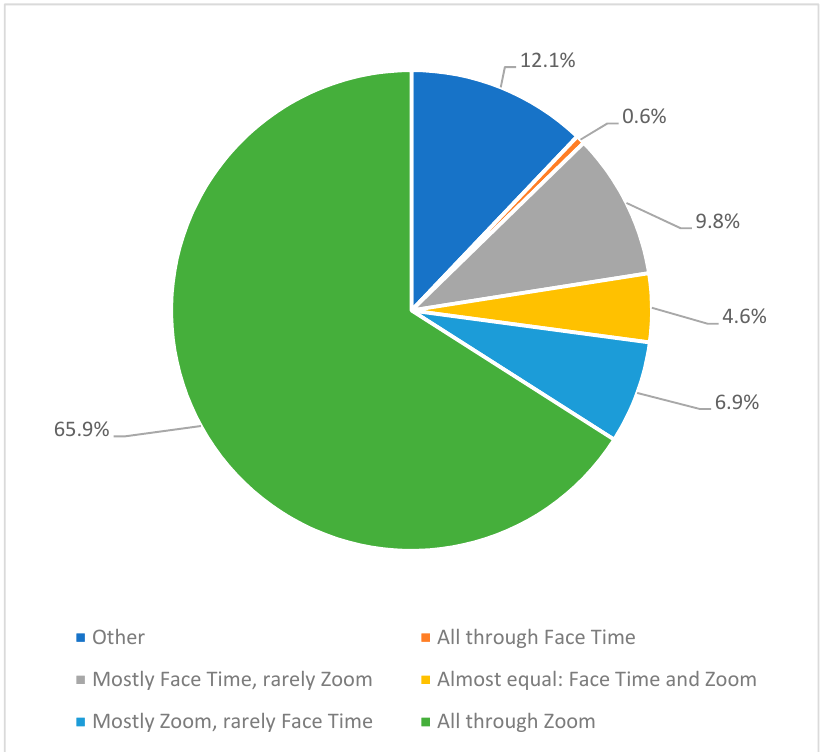
Figure 2. Video conferencing tools used by faculty members.